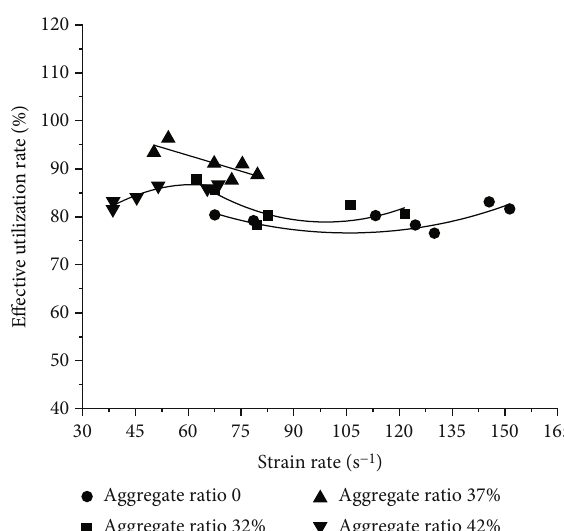
Figure 11: The relationship between the e ff ective utilization rate of energy absorption of specimens and the strain rate.